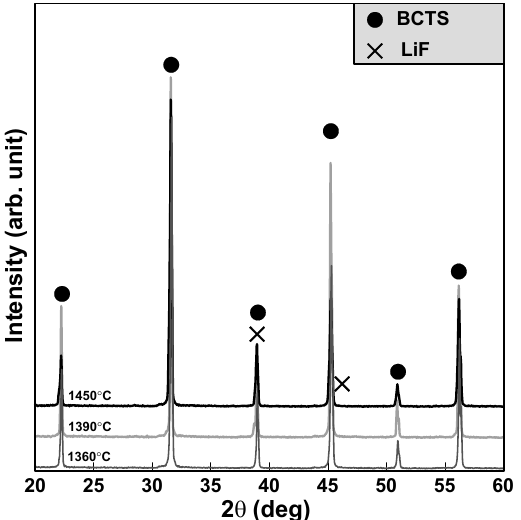
Figure 1. X ‐ ray diffraction patterns of (Ba 0.95 Ca 0.05 )(Ti 0.93 Sn 0.07 )O 3 (BCTS)–0.07LiF sheets.